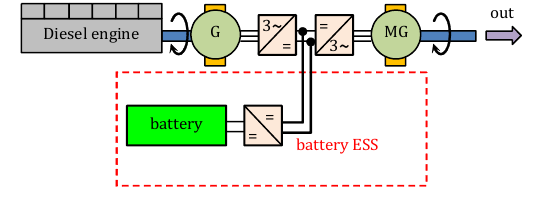
Fig. 13. A parallel hybrid drive of an internal combustion engine (DE) with a system of batteries operating in series with an electric motor in